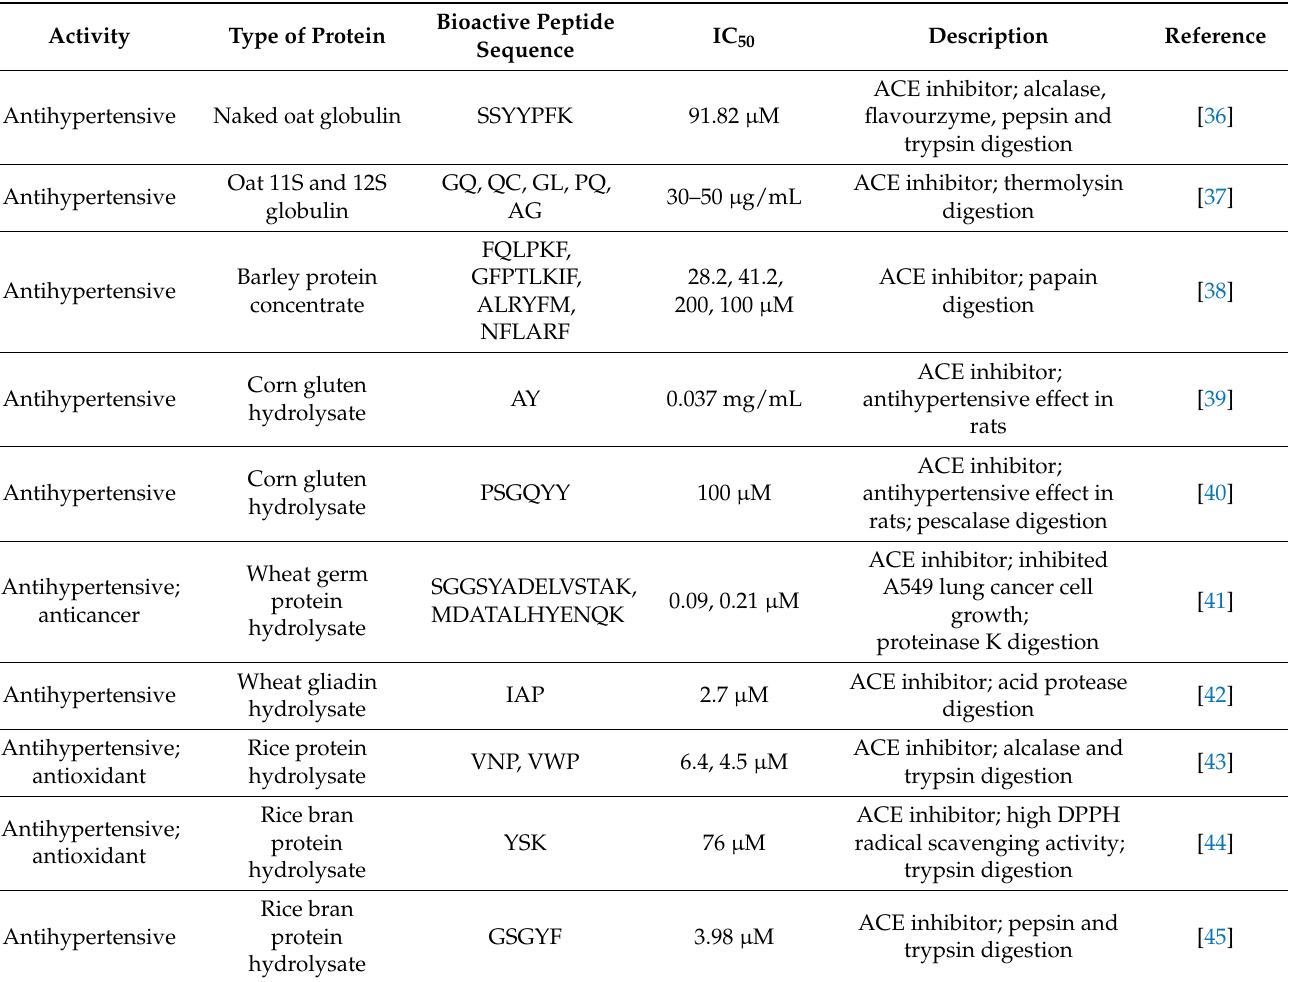
Table 1. Bioactive peptide sequences from some proteins derived from whole